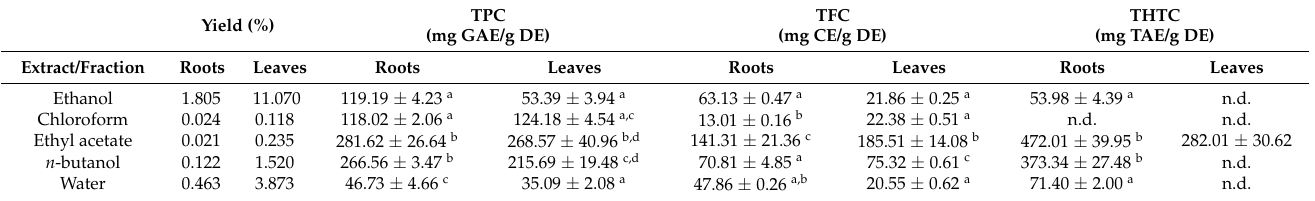
Table 1. Extraction yields and total phenolics, flavonoids, and hydrolysable tannins content of ethanol extracts from L. intricatum and obtained